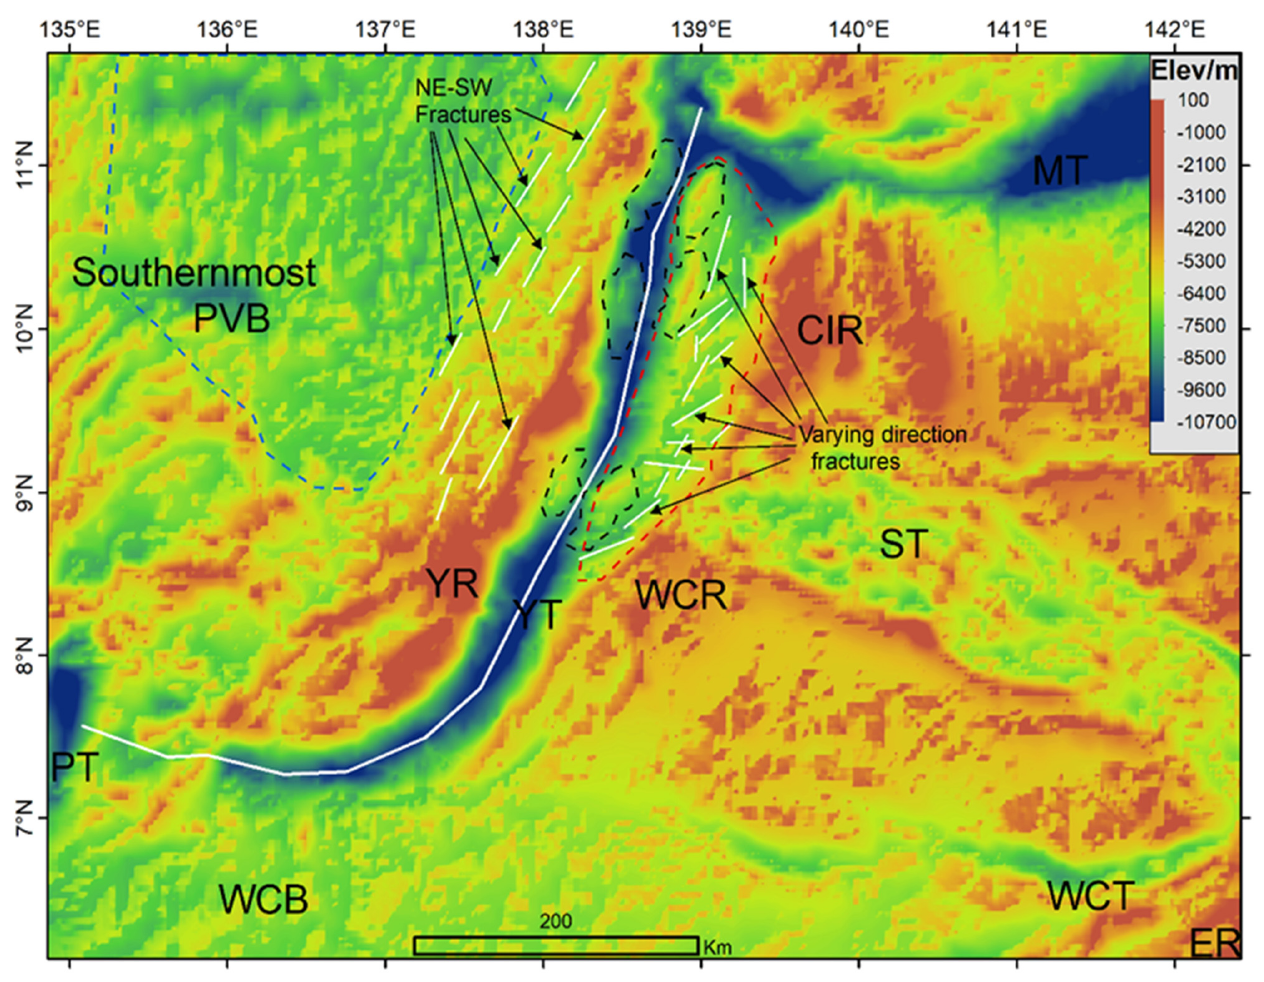
Figure 2. The bathymetric characteristics of the southernmost Parece Vela Basin, Yap arc, arc-ward trench slope, Yap Trench axis, sea-ward trench slope, and the CR. The red-dashed polygon outlines the area of horsts and grabens and normal-faulted structures. The black-dashed polygons outline the corresponding bathymetry highs on the arc-ward and sea-ward trench slopes. The J-shaped solid white line delineates the Yap Trench axis. The blue-dashed polygon delineates the area of the southernmost Parece Vela Basin containing seafloor fabrics and depressions. See Figure 1 for abbreviations.